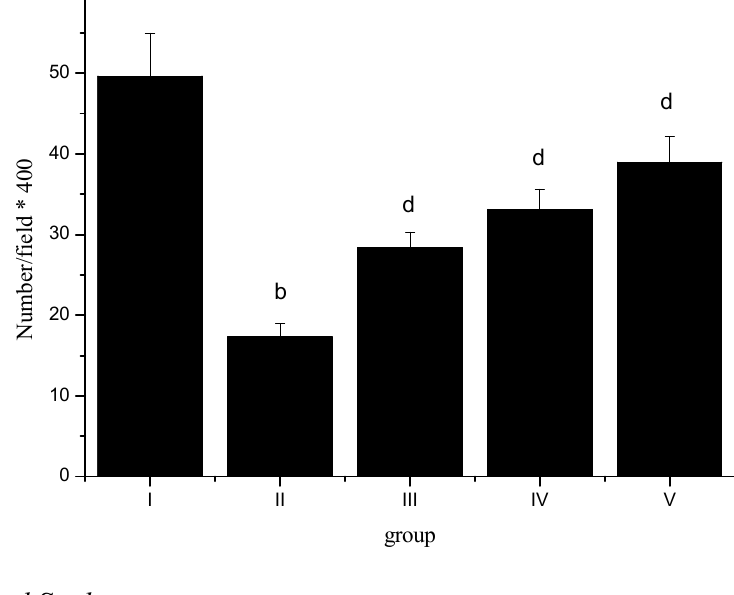
Figure 1. Effect of sevoflurane postconditioning on normal pyramidal neurons